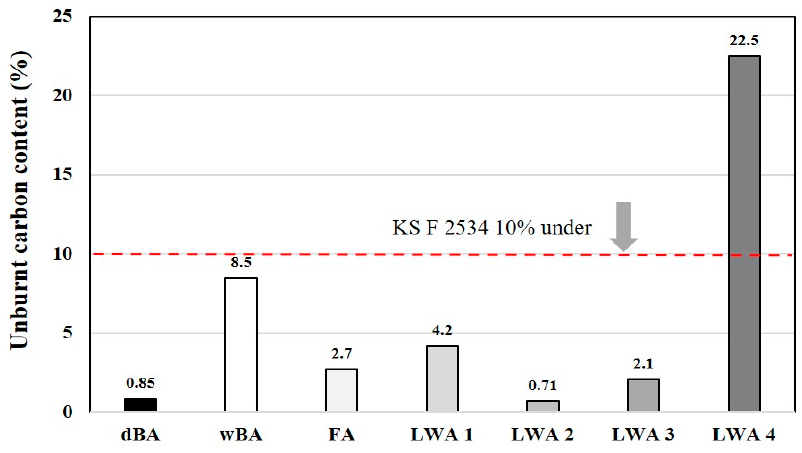
Figure 12. Unburnt carbon of dBA.